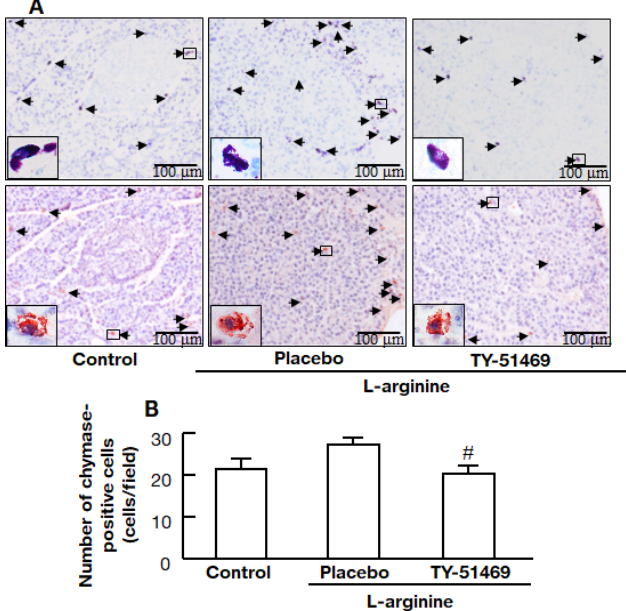
Figure 6. Effects of TY-51469 on numbers of chymase-positive cells. Representative images of pan- creata stained with toluidine blue (upper images) and immunostained with anti-chymase antibody (lower images) from the control, placebo-, and TY-51469-treated hamsters 8 h after the injection of L-arginine ( A ). The arrows show toluidine blue-stained cells (mast cells) and chymase-positive cells ( A ). Original magnification 200 × (inset: 1000 × ) ( A ). The number of chymase-positive cells in control, placebo-, and TY-51469-treated groups 8 h after the injection of L-arginine (control group: n = 6, placebo-treated group: n = 8, TY-51469-treated group: n = 8) ( B ). Values represent means ± SEM. # p < 0.05 vs. placebo-treated